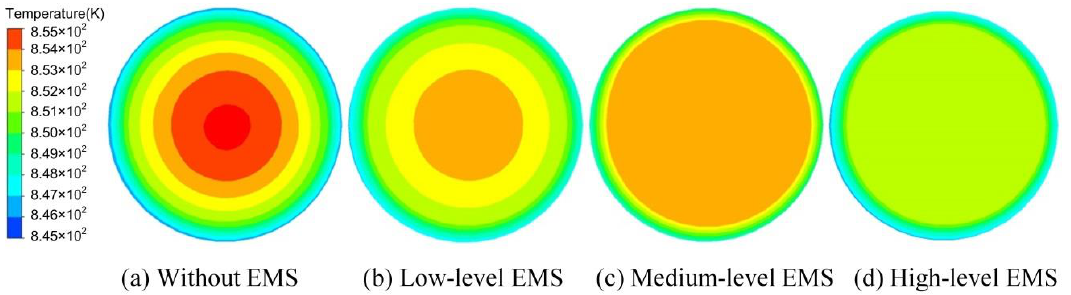
Figure 14. Results of the temperature field under different operating conditions (time: 14.56 s).